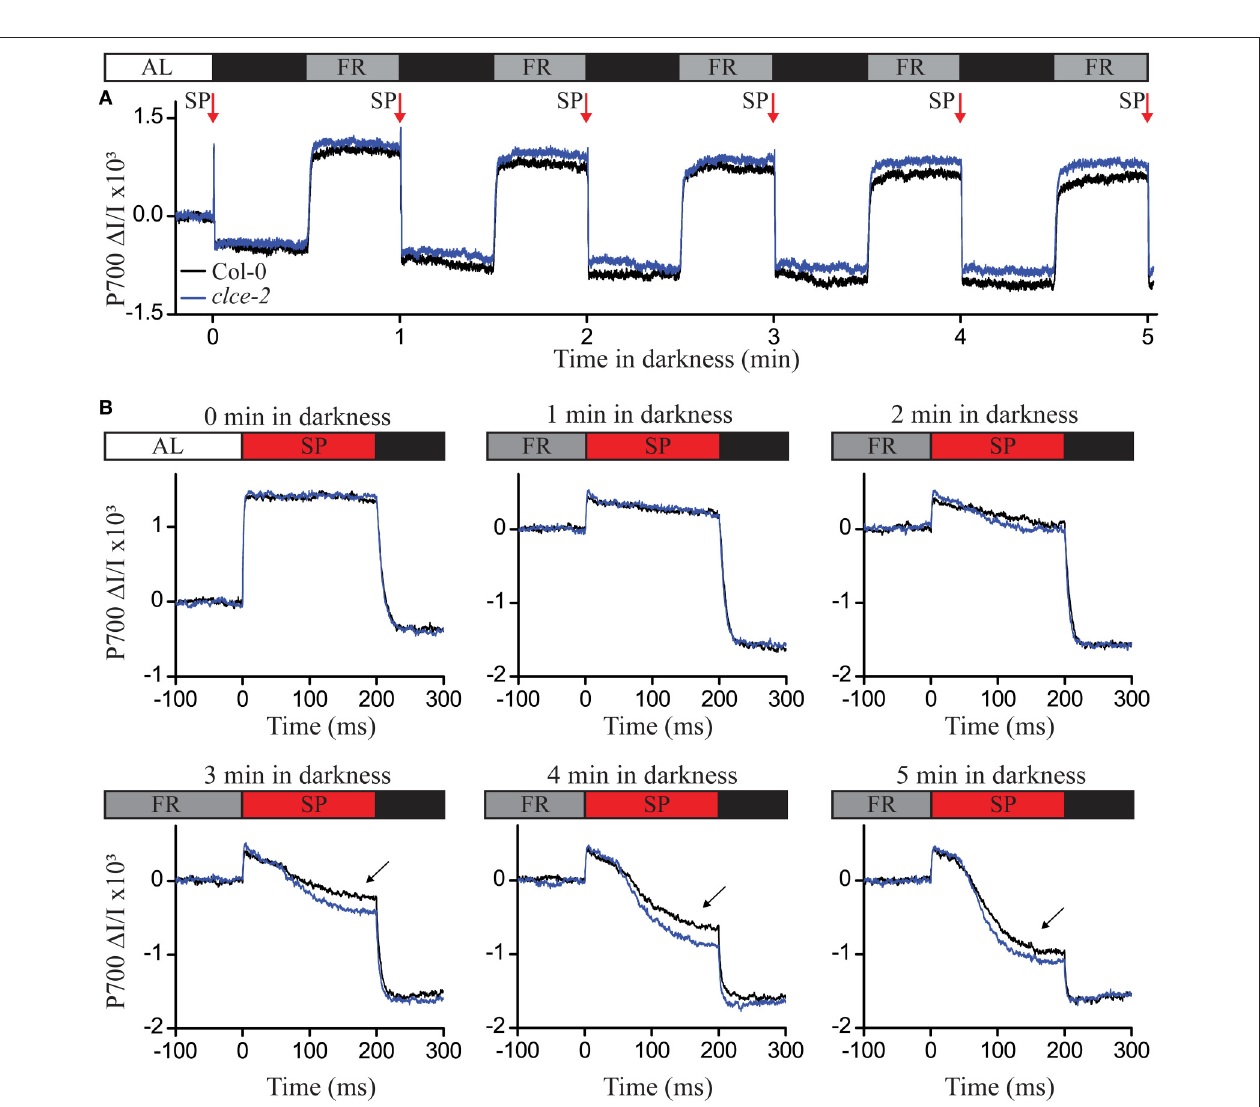
FIGURE 7 | P700 oxidation-reduction kinetics following different dark adaptation intervals. Wild-type and mutant plants have been illuminated with actinic light (AL) of 120 µ mol photons m − 2 s − 1 for 1h before recording the P700 signal as difference in transmittance at 875nm and 830nm. The steady state P700 signal in the light was recorded for 15s, followed by 5 cycles of 30s (indicating the P700 reduced state) and 30s of far-red (FR) illumination in darkness (indicating the P700 oxidized state) (A) . Before AL was switched off, and after each cycle of darkness and FR, a saturation pulse of 200ms at 20,000 µ mol photons m − 2 s − 1 (SP red arrow) was applied to record the P700 reduction kinetics (B) . The curves were normalized to the initial P700 values in light ( A , B —0min in darkness) or after the FR illumination (B) . Black arrows indicate differences in P700 reduction kinetics after 3, 4, and 5min in darkness. The plotted data are means of measurements from 5